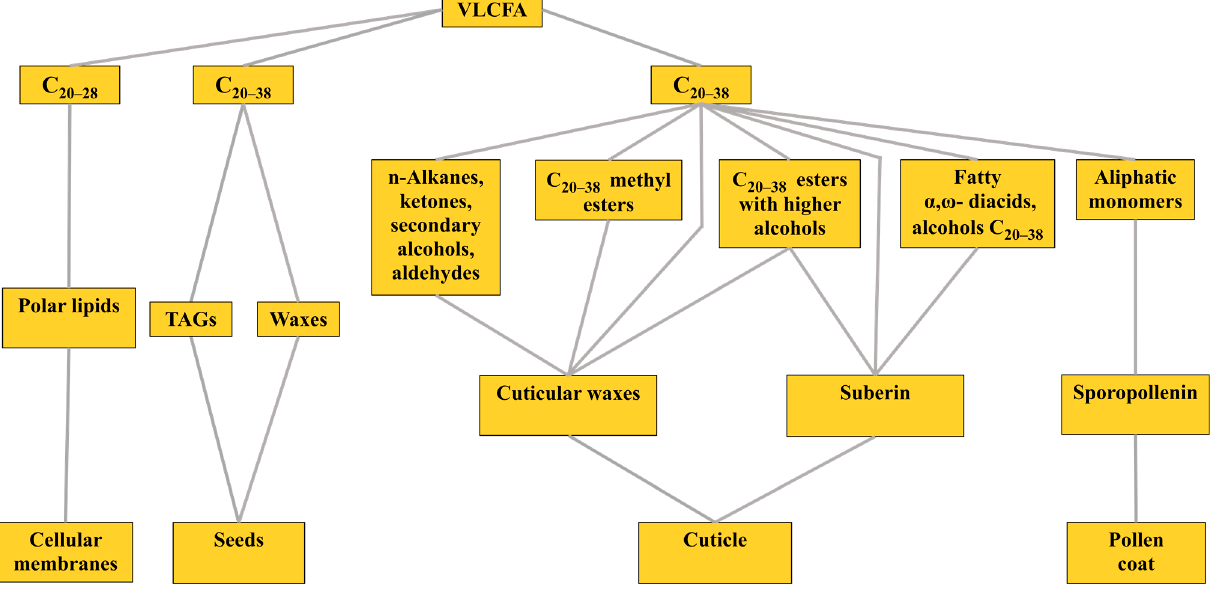
Figure 1. The distribution of very-long-chain fatty acids (VLCFA) in plant cells and tissues. C 20–28 VLCFA are the components of polar lipids (PL) of cell membranes. C 20–38 VLCFA are found in developing seeds as a part of reserve triacylglycerols and waxes and are also included in cuticular waxes, suberin and sporopollenin, which form a surface barrier on leaves, stems, roots and pollen shells, respectively.